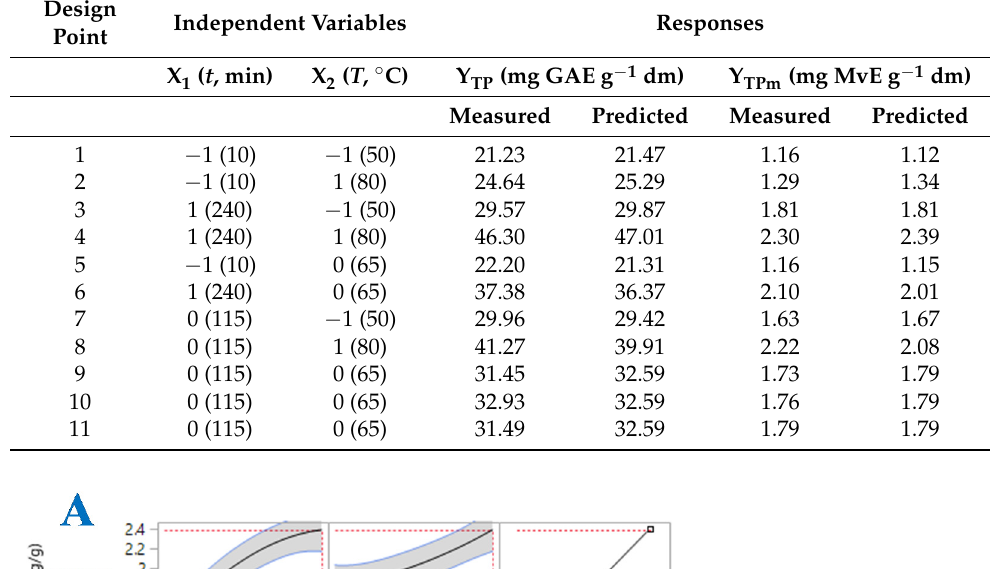
Table 3. Points of the experimental design with the corresponding measured and predicted values of the responses.